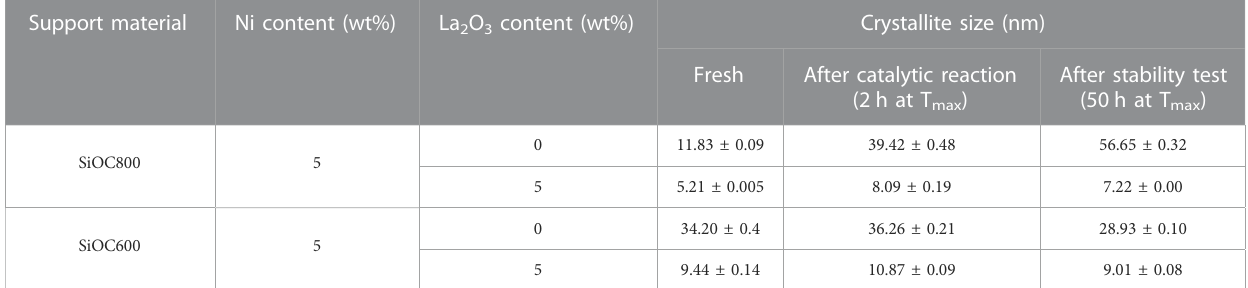
TABLE 1 Ni crystallite size estimated using the Scherrer equation of fresh and used (after catalytic tests and after stability tests) catalysts with and without La- modi fi cation. Support material